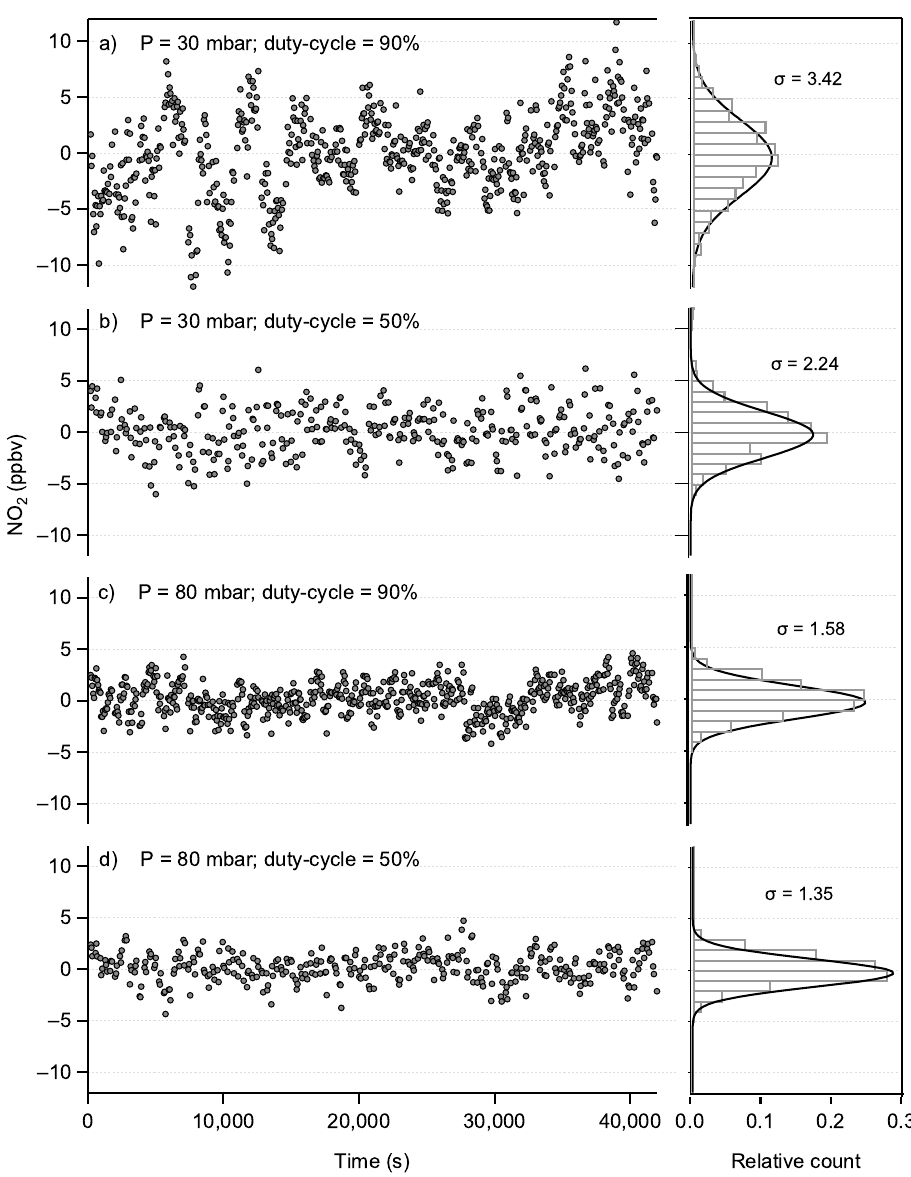
Figure 5. Zero-drift corrected and 1min averaged time-series of 12h long measurements of syn- thetic air using two different sample pressures (30 and 80mbar) and duty cycles of 50% and 90%, respectively. The associated histograms with a Gaussian fit indicate the spread of the data for each